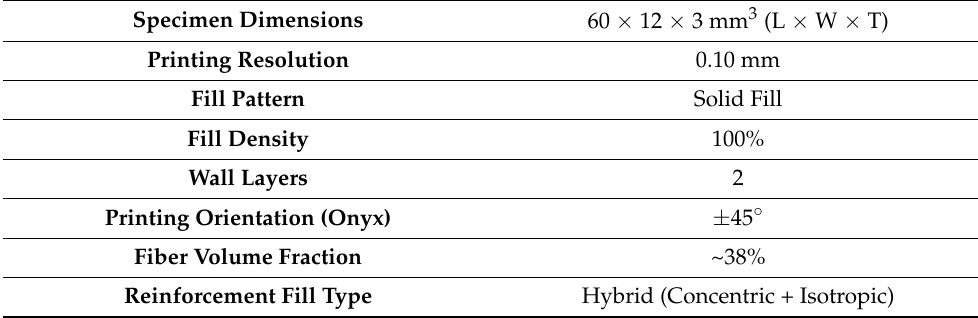
Table 1. Specimen Specifications and 3DP